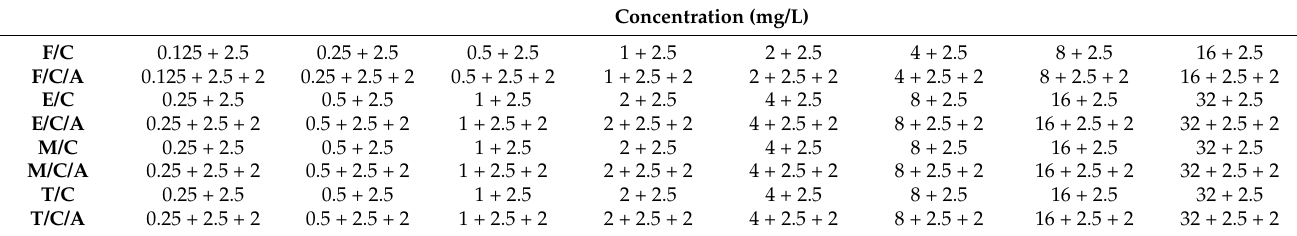
Table 6. Concentrations of ertapenem, faropenem, meropenem and tebipenem tested in combina- tion with amoxicillin and clavulanate (in mg/L). F, faropenem; C, clavulanate; A, amoxicillin; M, meropenem; E, ertapenem; T,